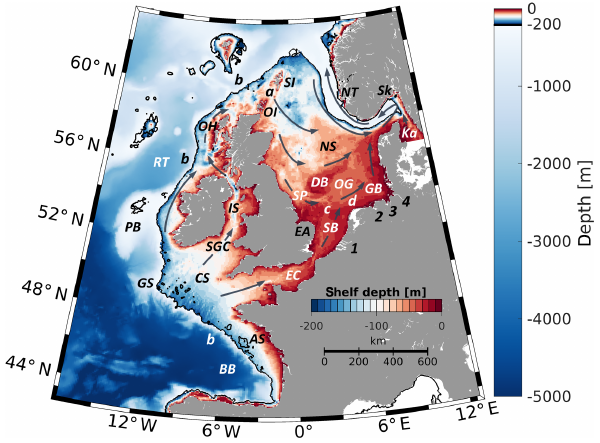
Figure 1. Bathymetry of the model domain. The shelf is defined as depths shallower than 200m (colour bar within the map). In this and all following figures, the 200m depth contour is highlighted with a black solid line. Grey arrows schematically show the general shelf sea circulation. The abbreviations used in the text are as follows: Armorican Shelf (AS), Bay of Biscay (BB), Celtic Sea (CS), Dog- ger Bank (DB), East Anglia (EA), English Channel (EC), German Bight (GB), Goban Spur (GS), Irish Sea (IS), Kattegat (Ka), North Sea (NS), Norwegian Trench (NT), Oyster Ground (OG), Outer He- brides (OH), Orkney Islands (OI), Porcupine Bank (PB), Rockall Trough (RT), Skagerrak (Sk), Southern Bight (SB), St. George’s Channel (SGC), Shetland Islands (SI), Silver Pit (SP), Fair Isle Cur- rent (a), European Slope Current (b), East Anglia Plume (c), Frisian Front (d), Rhine (1), Ems (2), Weser (3), and Elbe